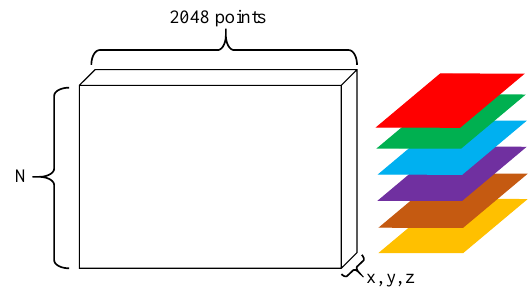
Figure 4. Schematic diagram of the data stack.